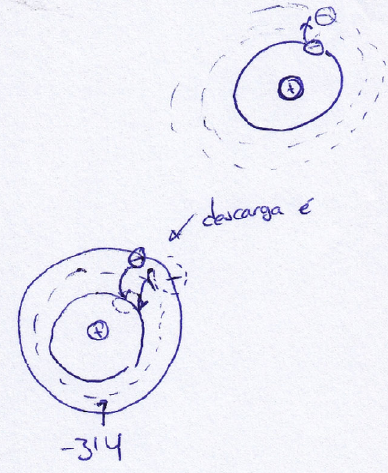
FIG. 3. Drawing by student 20 to explain atomic transitions and how they relate to the emission spectrum. At the top, (s)he shows the absorption of energy produced by the electrical discharge and at the bottom, (s)he shows the possible transitions back to the fundamental